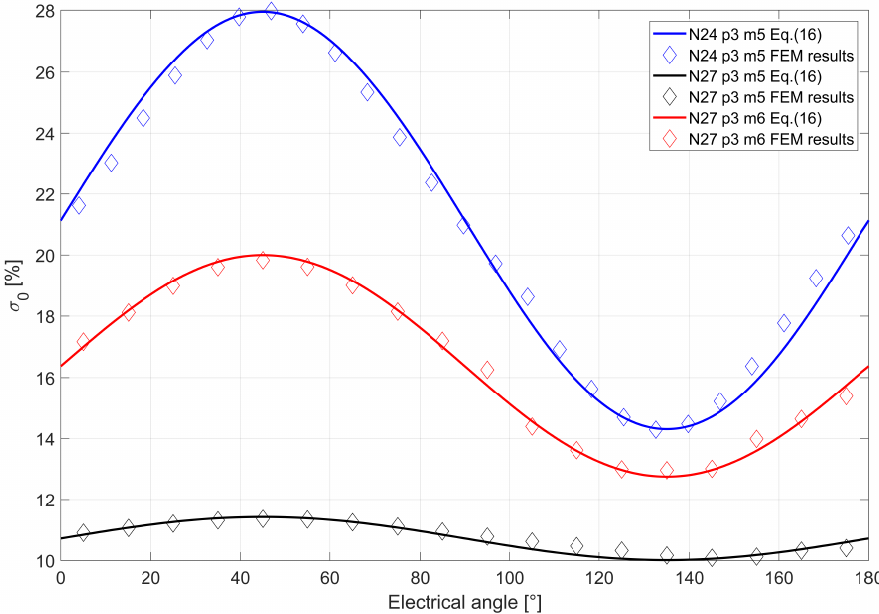
Figure 12. FEM validation for asymmetrical Goerges polygons.